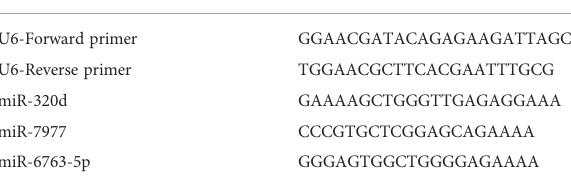
TABLE 2 Primers sequence